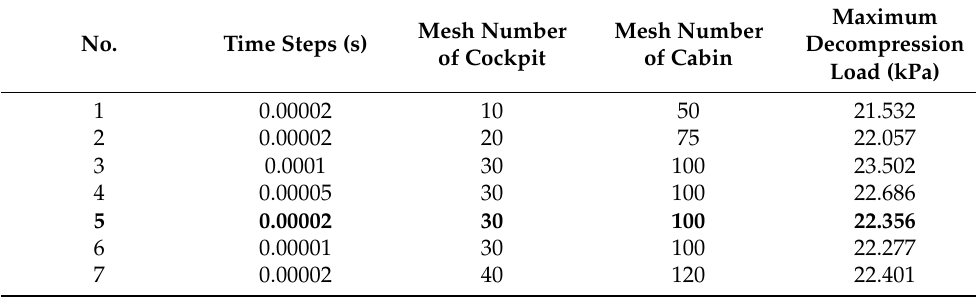
Table 4. Time-step-independence and mesh-independence verification of the 1-D model.